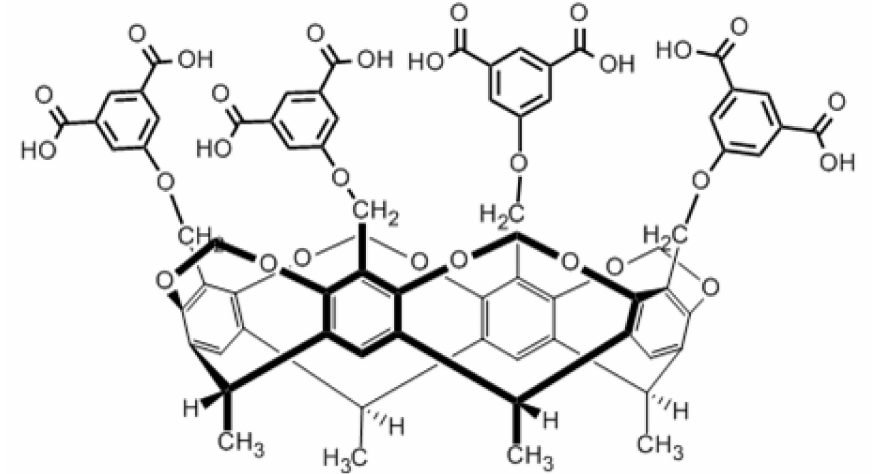
Figure 3. Structural formula of tetrakis(3,5-dicarboxyphenoxy) cavitand (“octacarboxy cavitand”).